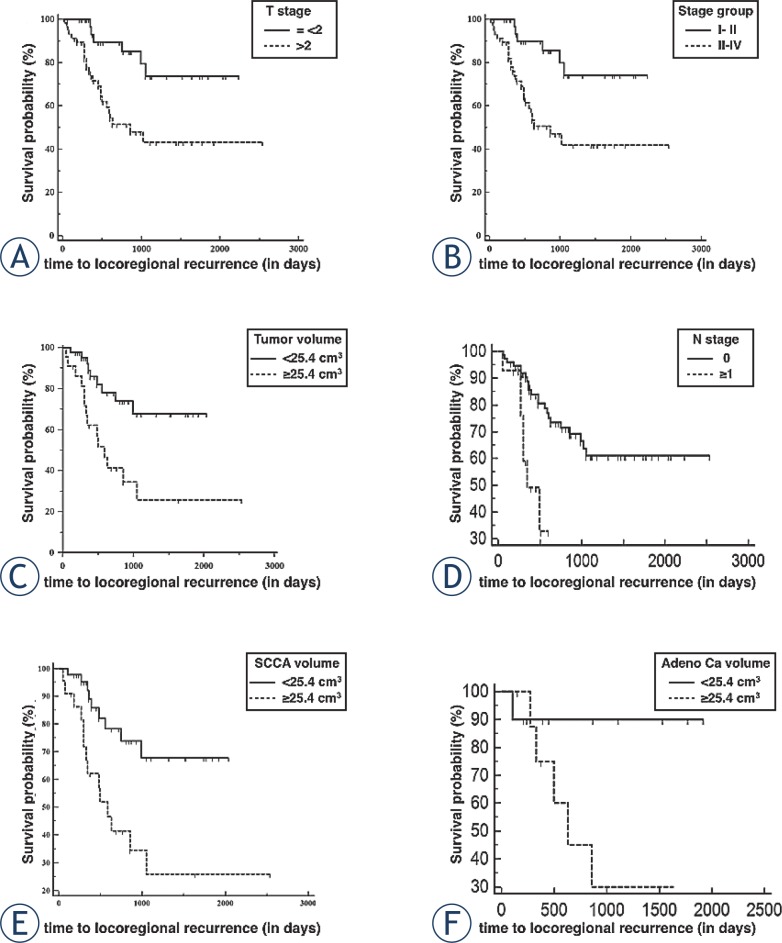
Kaplan-Meier survival curves for locoregional recurrence according to T-stage groups (A), American Joint Committee on Cancer (AJCC) stage groups (B), radiologic tumour volume (C) and N-stages (D). Subgroup analyses by tumour volume for squamous cell carcinoma (E) and adenoracinoma (F).